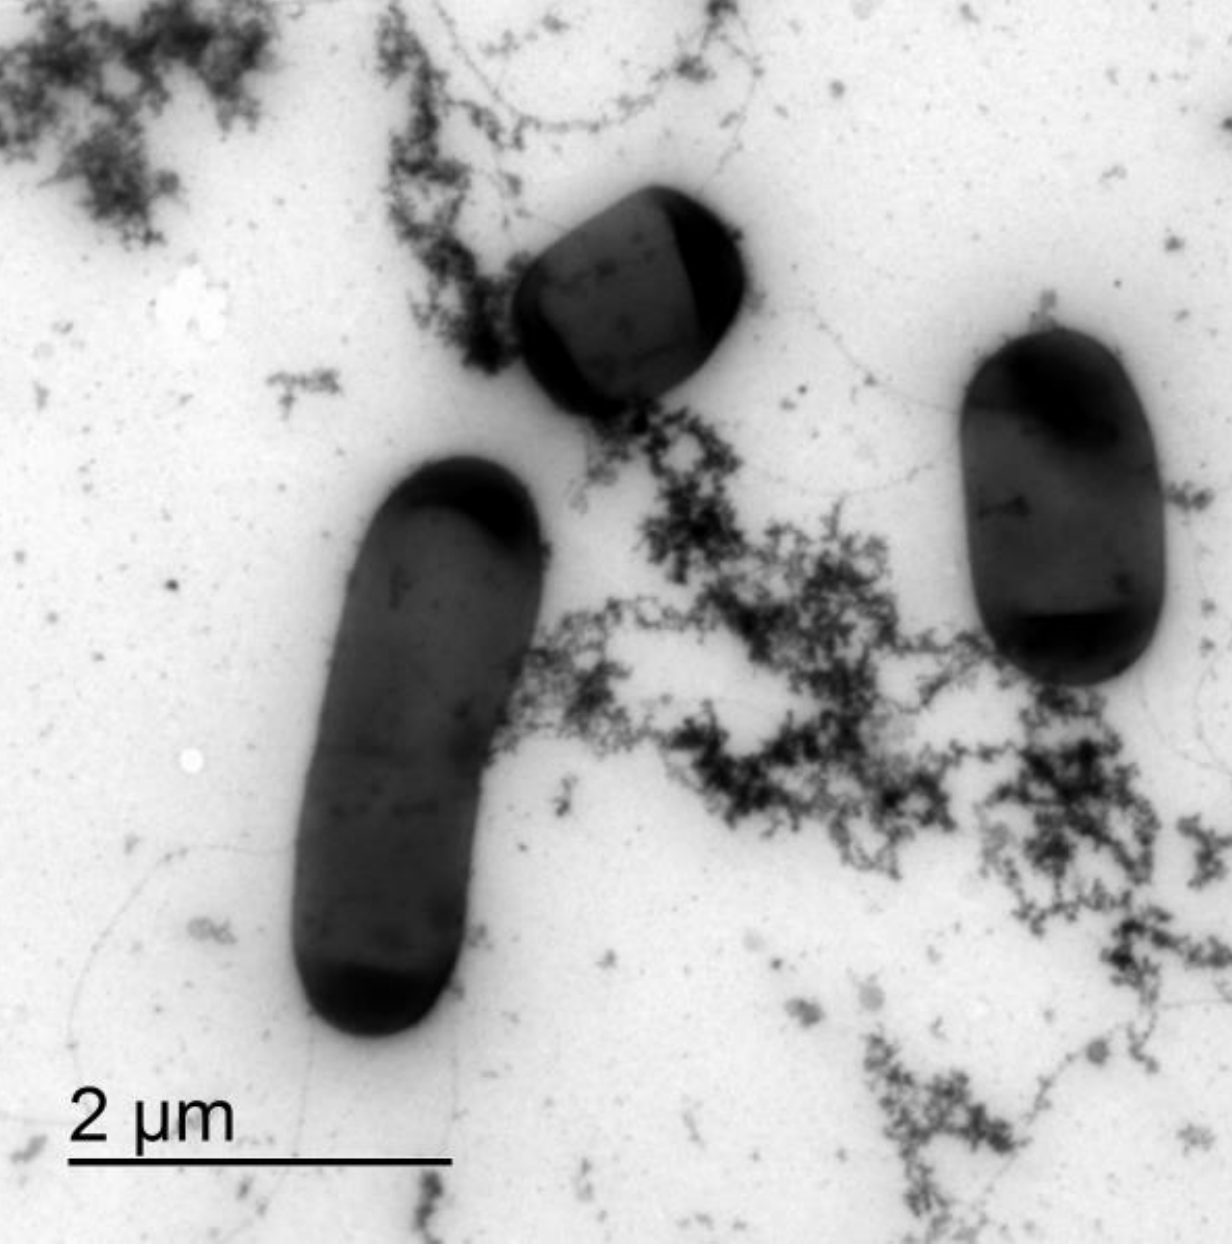
Figure 1. TEM of B. subtilis wt microcolony in the exponential growth phase after 2.5 h of incubation. Bacterial cells are interconnected via the extracellular matrix components.